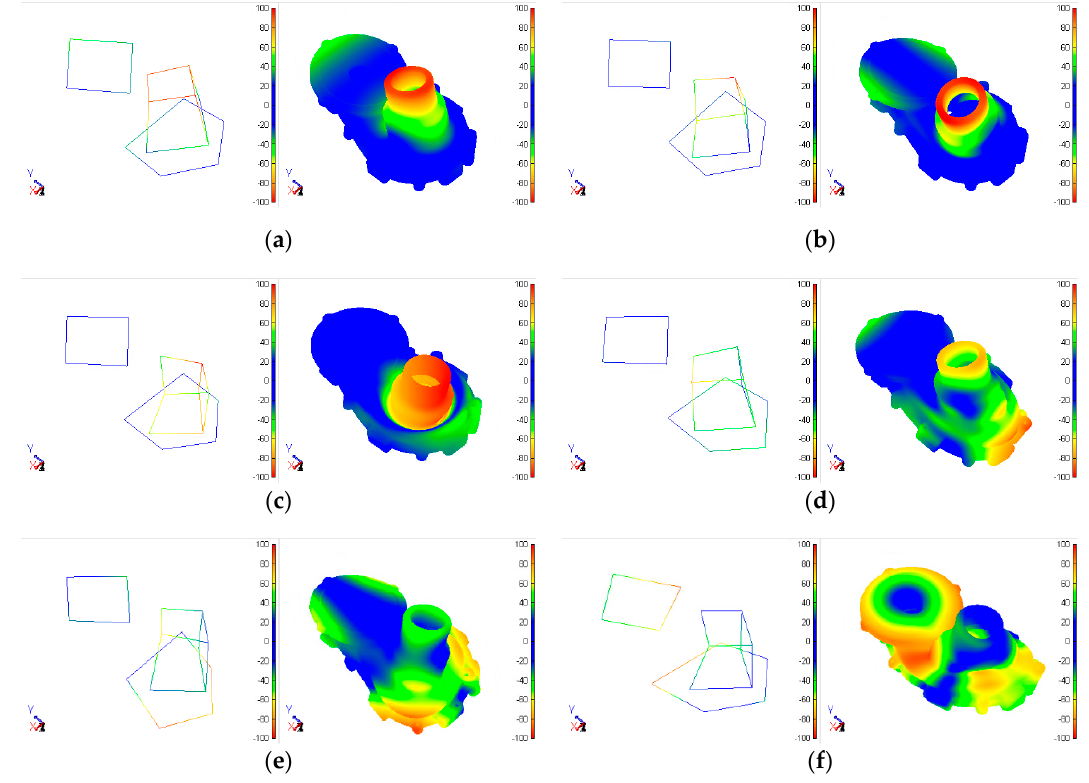
Figure 7. Comparison of the mode shape between EMA (left) and FEA (right). ( a ) 1st mode; ( b ) 2nd mode; ( c ) 3rd mode; ( d ) 4th mode; ( e ) 5th mode; ( f ) 6th mode.